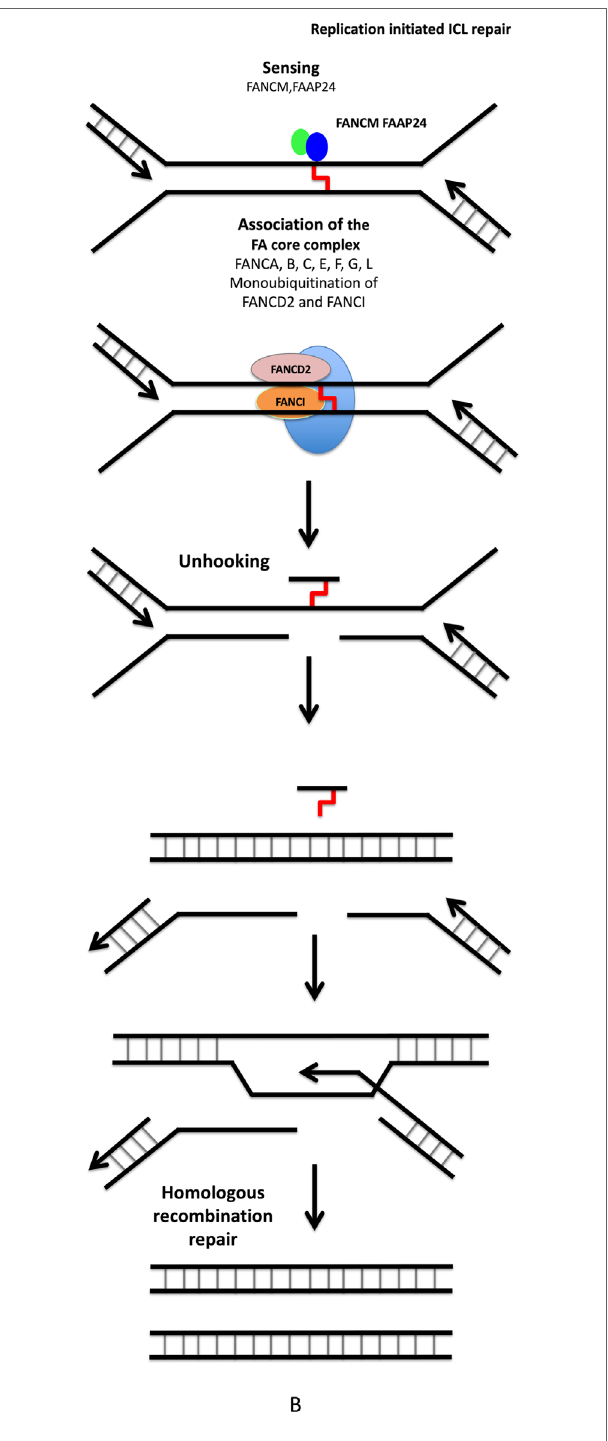
FIGURE 3 | DNA interstrand crosslink repair. ICL repair can be initiated either at a stalled RNA polymerase (A) or at a replication fork (B) . (A) ICLs in DNA will stall RNA polymerase during transcription. The RNA polymerase will either backtrack or be degraded during subsequent repair involving translesion (TLS) polymerases and NER pathway. (B) The removal of ICL during S and G2 phases involves the Fanconi anemia pathway, with sensing of ICL by FANCM, and then recruitment of protein complex, resulting in ICL removal, creation of DSB, which is repaired by homologous